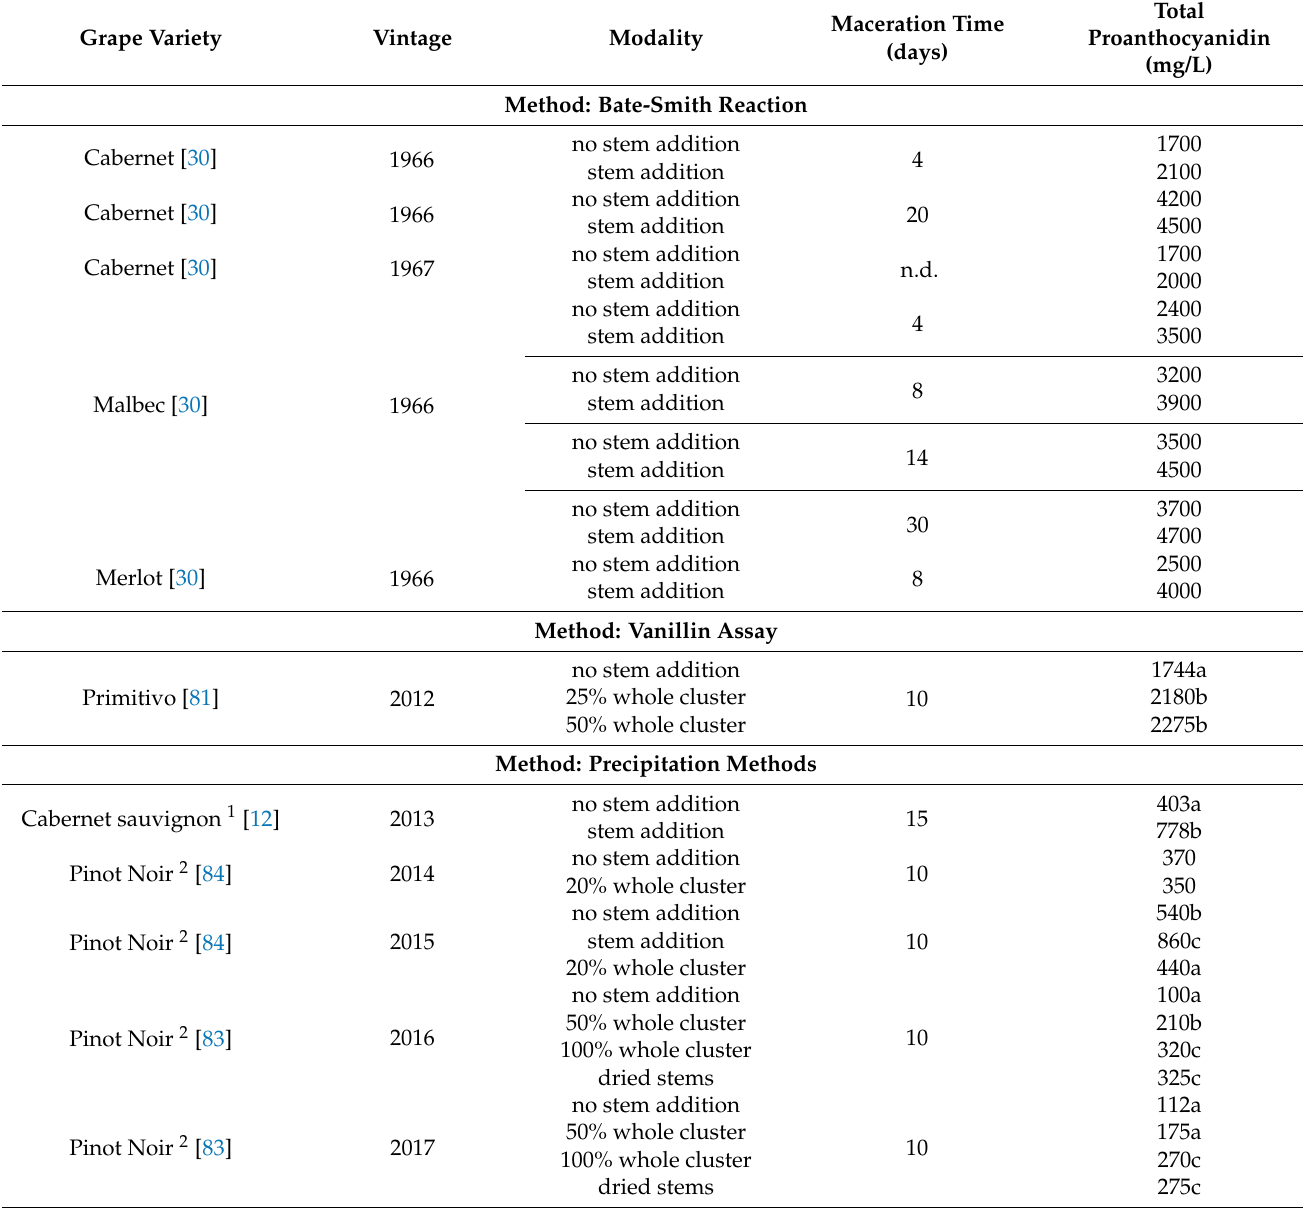
Table 17. Impact of stems during winemaking on total proanthocyanidin content (for each study, different letters indicate significant statistical